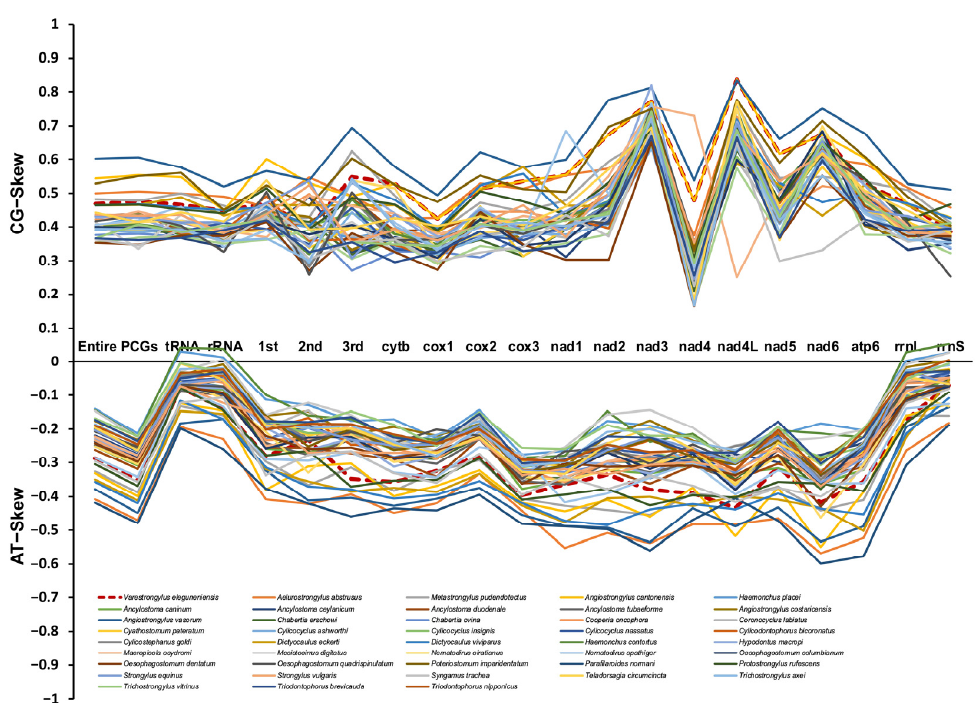
Figure 2. The GC and AT skews for mtDNAs of 21 different regions (entire mtDNA, 12PCGs, rRNAs, tRNAs, the 1st site in codon, the 2nd site in codon, the 3rd site in codon, rrnL , rrnS , and each single PCG) within the 43 Strongylida mtDNAs. Different species are indicated by different colored lines graph.